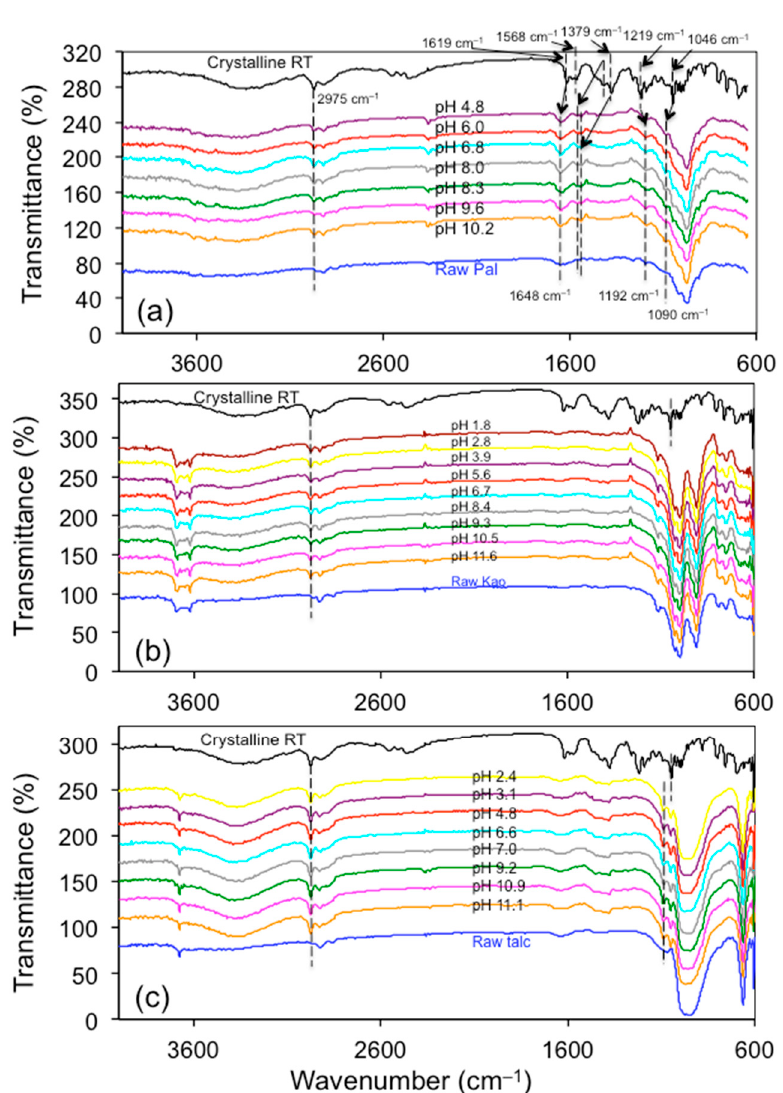
Figure 7. FTIR spectra of the RT loaded Pal ( a ), Kao ( b ), and talc ( c ) under different equilibrium solution pHs.